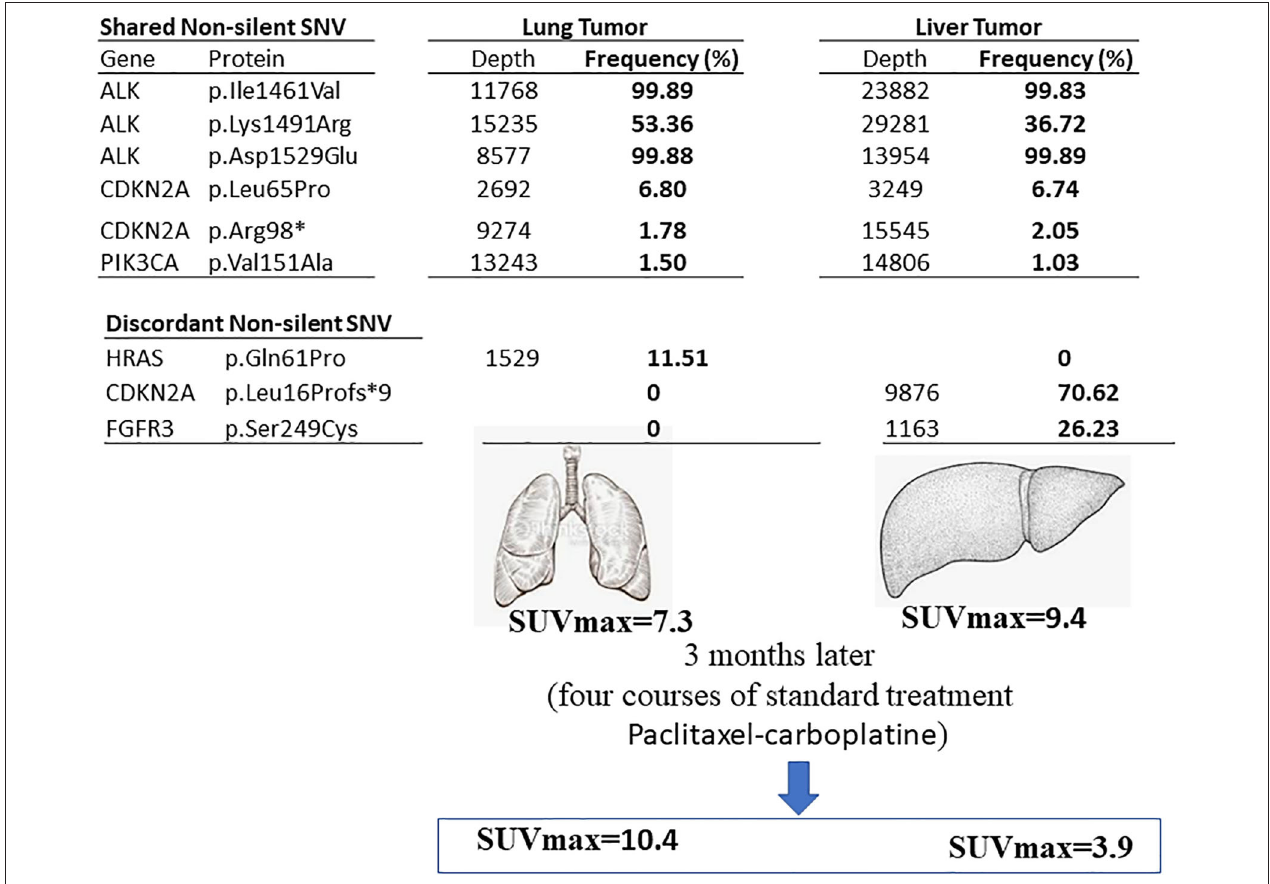
FIGURE 3 | Summary of the current finding. The genetic variants found in primary lung tumor (left) and liver (right) metastasis sites in the lung SqCC patient. The shared and discordant non-silent SNV are mentioned with the frequency percentage.